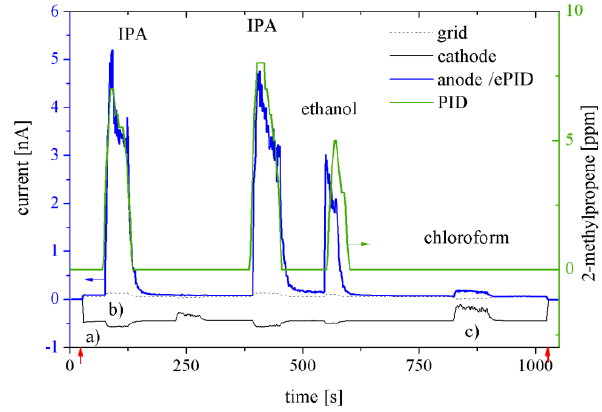
Figure 12. Measured ionization signal of PID calibrated to 2- methylpropene (green signal) and compared to an ePID (blue sig- nal). (a) Emission of photoelectrons out of the cathode, (b) ioniza- tion by photons, and (c) ionization by emitted photoelectrons (Zim- mer et al.,